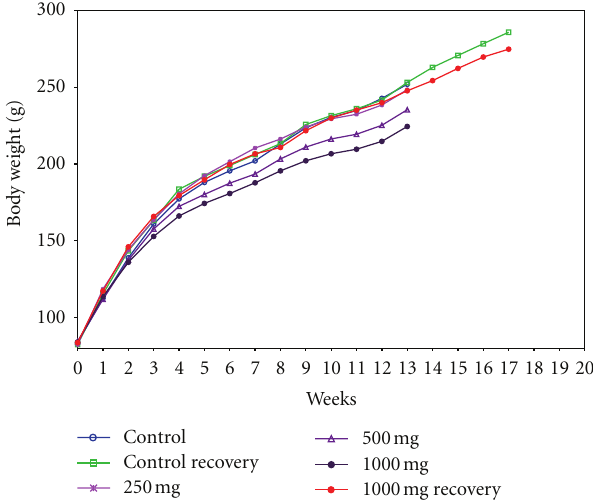
Figure 2: Group mean body weight of female rats orally adminis- tered with Zigbir (cid:2) for 90